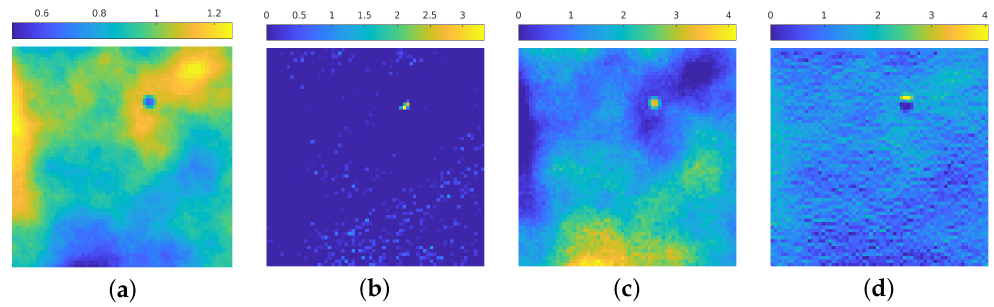
Figure 4. ( a – d ): 4 out of 8 activation of the 1st block in the contracting path. The images are displayed in different color scale, since the ranges of the activation values differ by a large amount between filters.